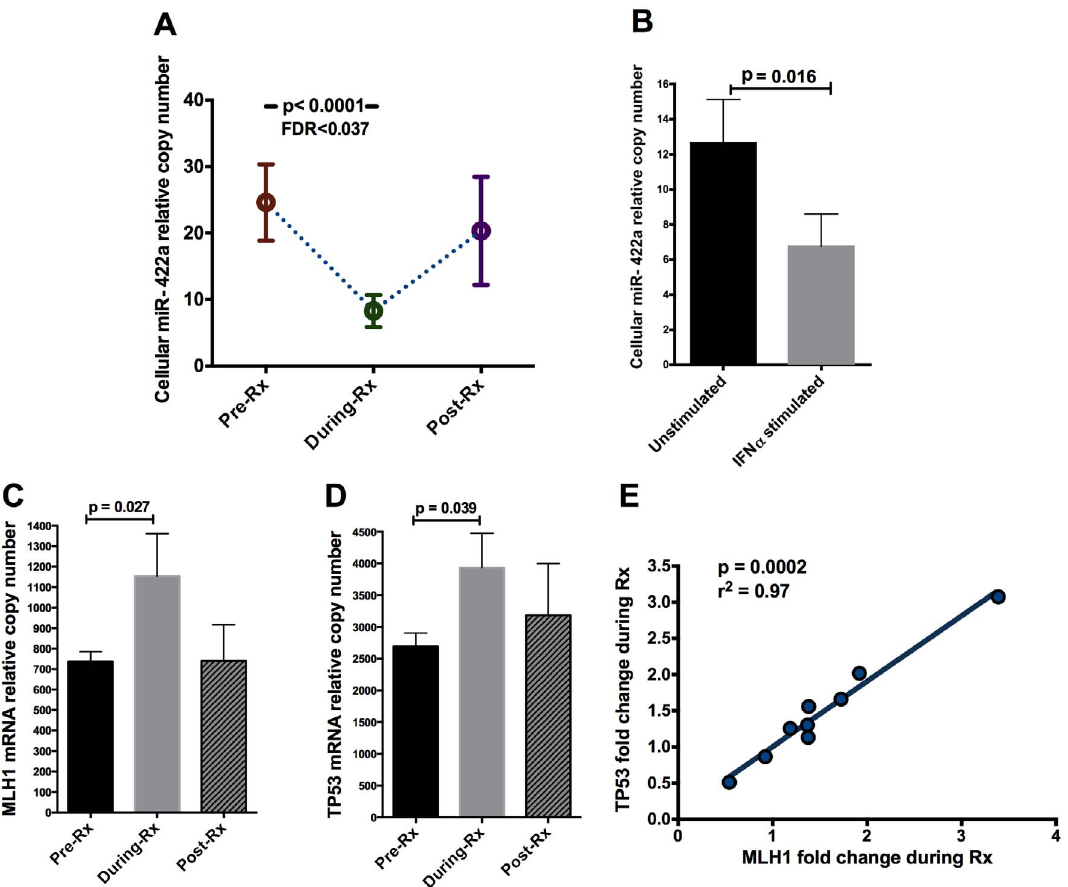
Figure 2. miR-422a is modulated by IFN- a treatment. (A) Expression of miR-422a in PBMC in vivo before, during and after IFN- a /RBV treatment (labeled as ‘‘Rx’’). Error bars represent SEM. P-value was obtained using a paired t-test and FDR is reported. (B) Effects of IFN- a on the expression of miR-422a in CD4 + T cells in vitro ; cells were plated at a million cells per well and treated with either 5 U/ml of IFN- a or media as a negative control. (C) Expression of MLH1 in PBMC in vivo before, during, and after IFN- a /RBV treatment. (D) Expression of TP53 in PBMC in vivo before, during, and after IFN- a /RBV treatment. Error bars represent SEM. P-values were obtained using paired Wilcoxon tests. (E) Correlation between TP53 fold induction and MLH1 fold induction in PBMC in vivo during IFN- a /RBV treatment. P-value was obtained using Spearman’s rank test.